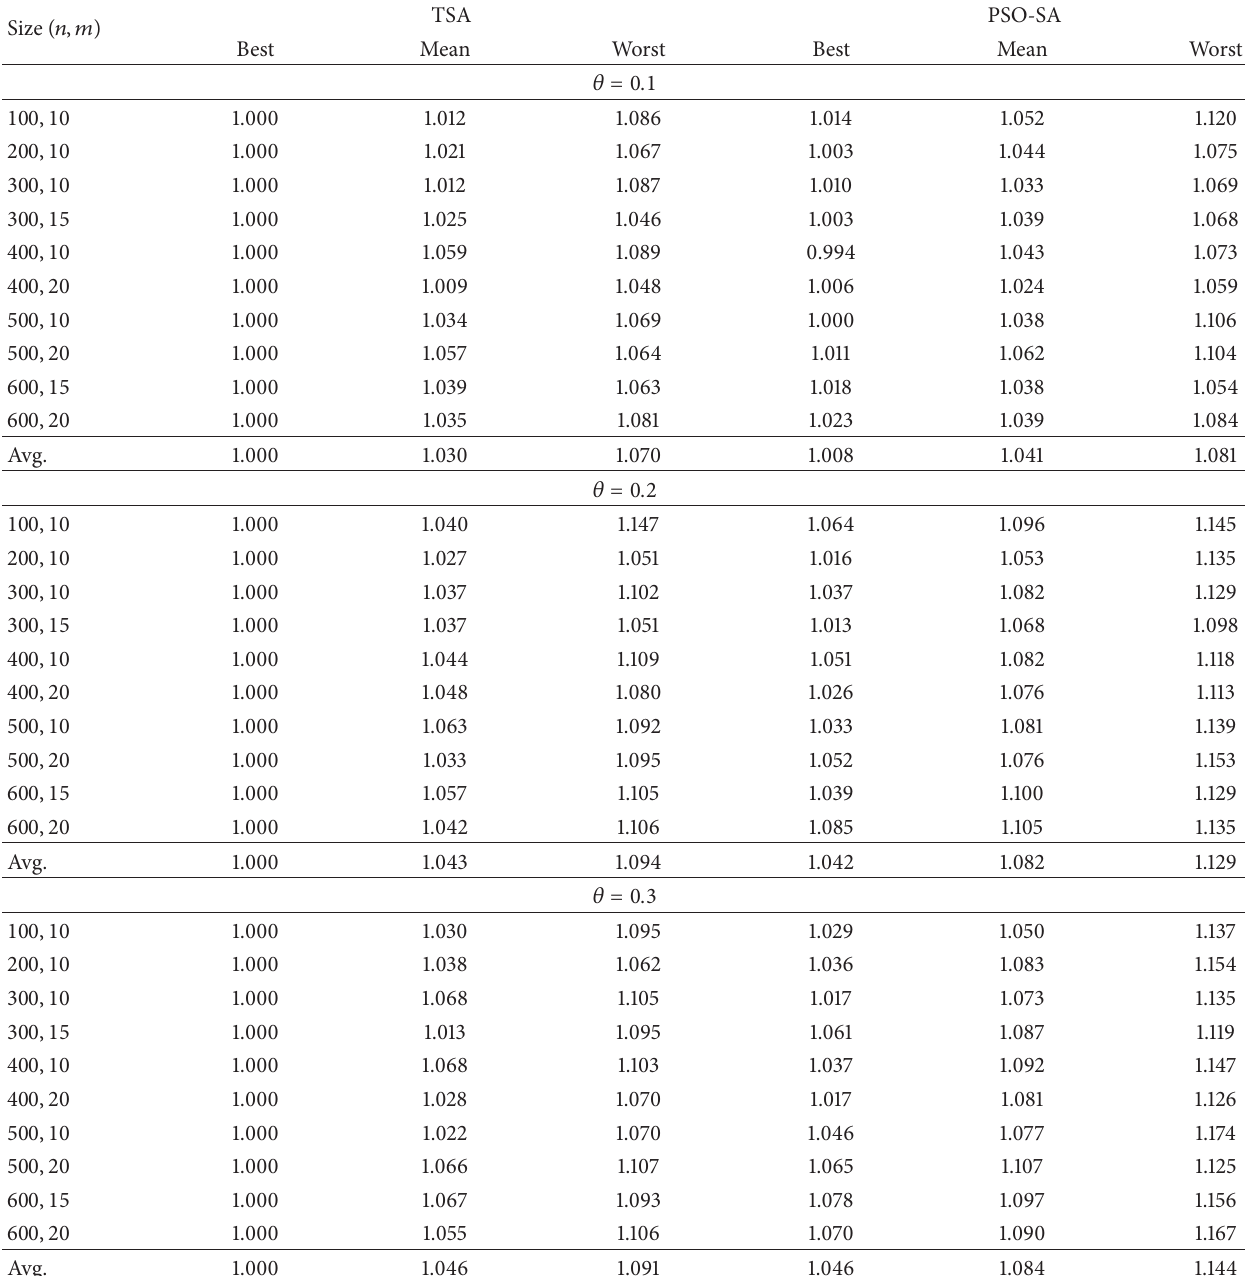
Table 3: The computational results under uniform